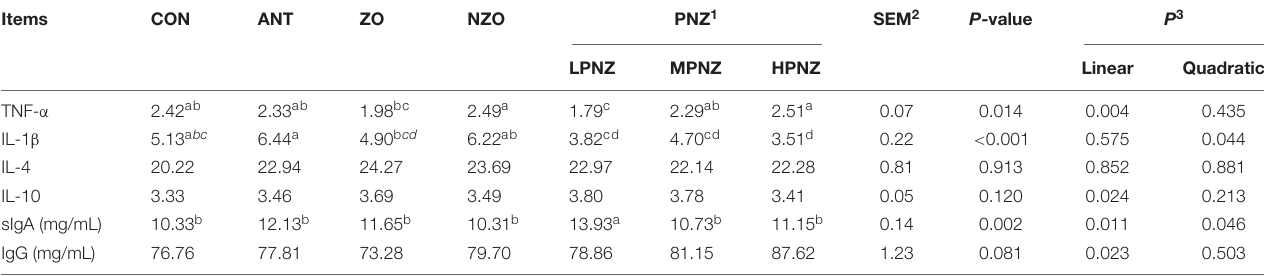
TABLE 5 | Effects of PNZ on the contents of cytokines and immunoglobulins in jejunal mucosa of weaned pigs (ng/gprot). Items CON